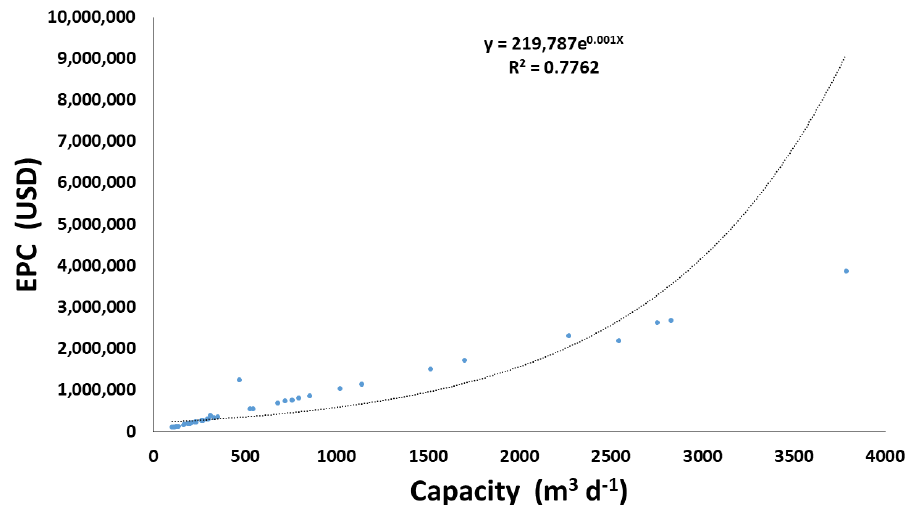
Figure 10. Correlation between initial investment and BWRO capacity. EPC = Engineering, procure- ment and construction.